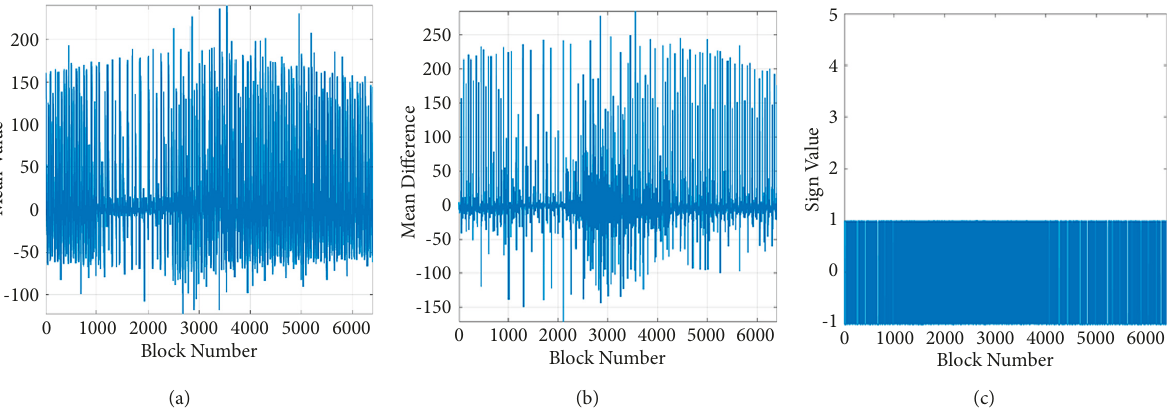
Figure 3: Mean key-based block swapping. (a) Mean block value. (b) Mean difference. (c) Sign of